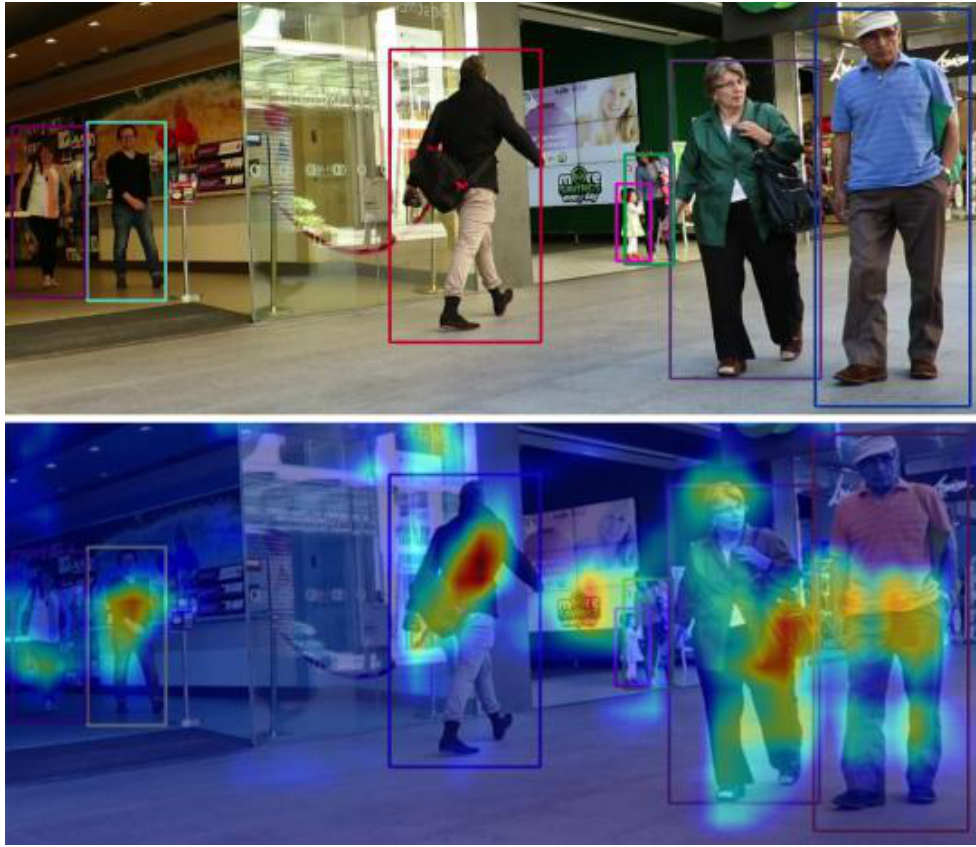
Figure 4. Tracking and its corresponding attention visualization result. We visualized the feature map in front of the tracking head in the form of a hot map. The upper part is a tracking result, and the lower part is the corresponding attention visualization result. The identifiable image in this figure is from the public dataset MOT16.